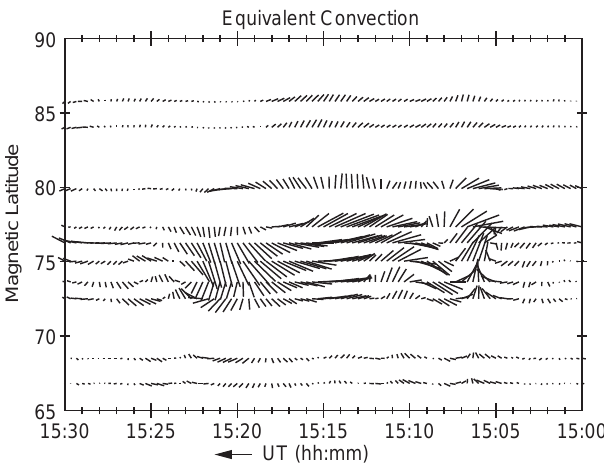
Fig. 7. Plot of the horizontal magnetic perturbation vectors corre- sponding to the variations of Fig. 5. The vectors have been rotated 90 (cid:176) counterclockwise and plotted every 20 s during the time interval between 1500 and 1530 UT. Note the time scale increases from right to left in order to display the east-west extension of the vortices that were traveling eastward